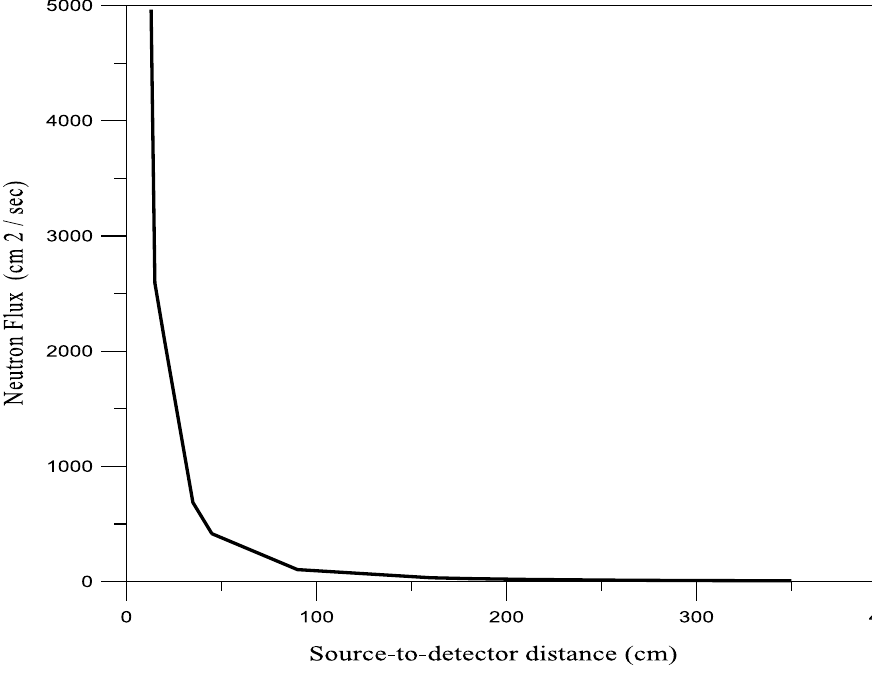
Fig. 2. The calculated neutron fl ux by MCNP5 at different distances from the source